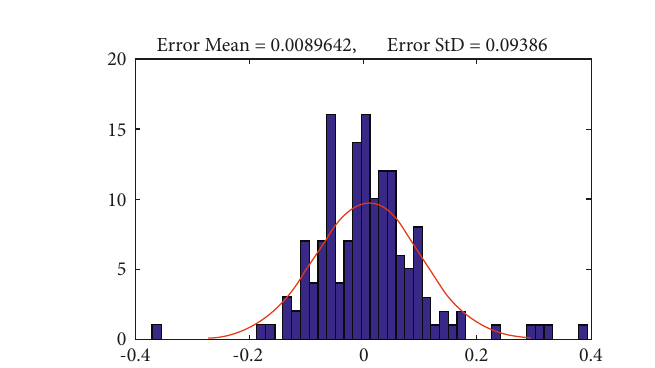
Figure 3: MSE and RMSE value of train data.